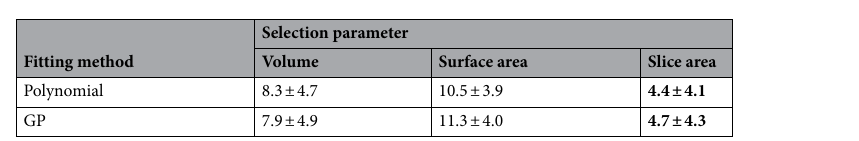
Table 7. Ejection fraction mean absolute difference comparison for polynomial and GP fitting a . a Represented as MD ± standard deviation. In bold, the best performing selection metric.